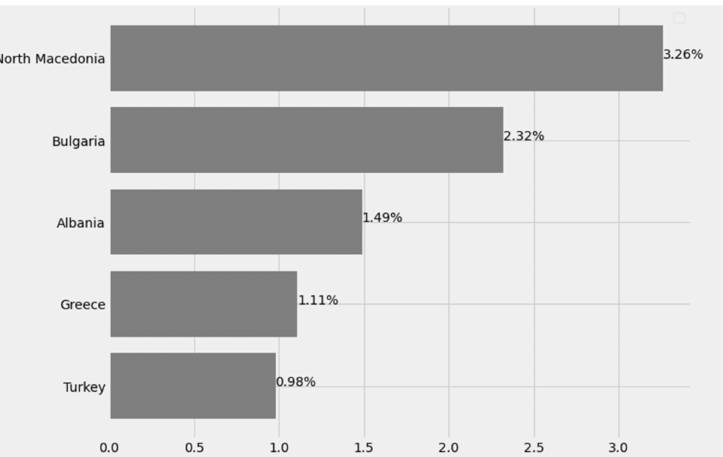
Figure 28. Percentage of population affected by global